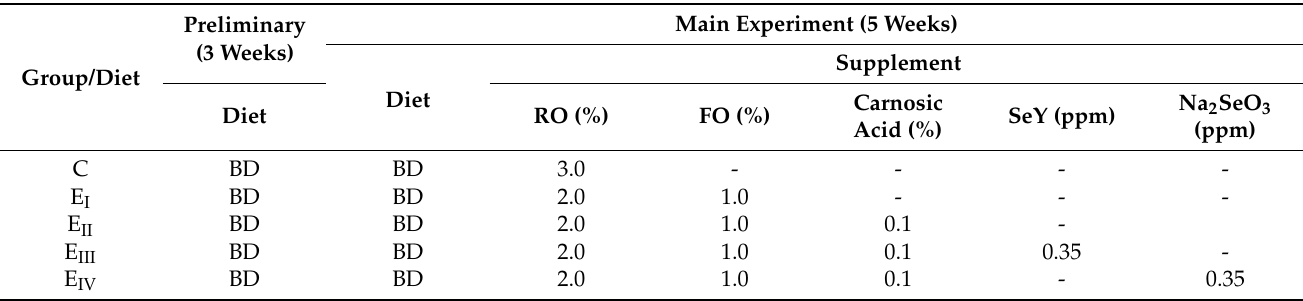
Table 1. Scheme of the study (diet and supplements’ consumption by particular group of lambs during main experiment). Main Experiment (5 Weeks) Preliminary (3 Weeks) Supplement Group/Diet Diet Carnosic Na 2 SeO 3 RO (%) FO (%)